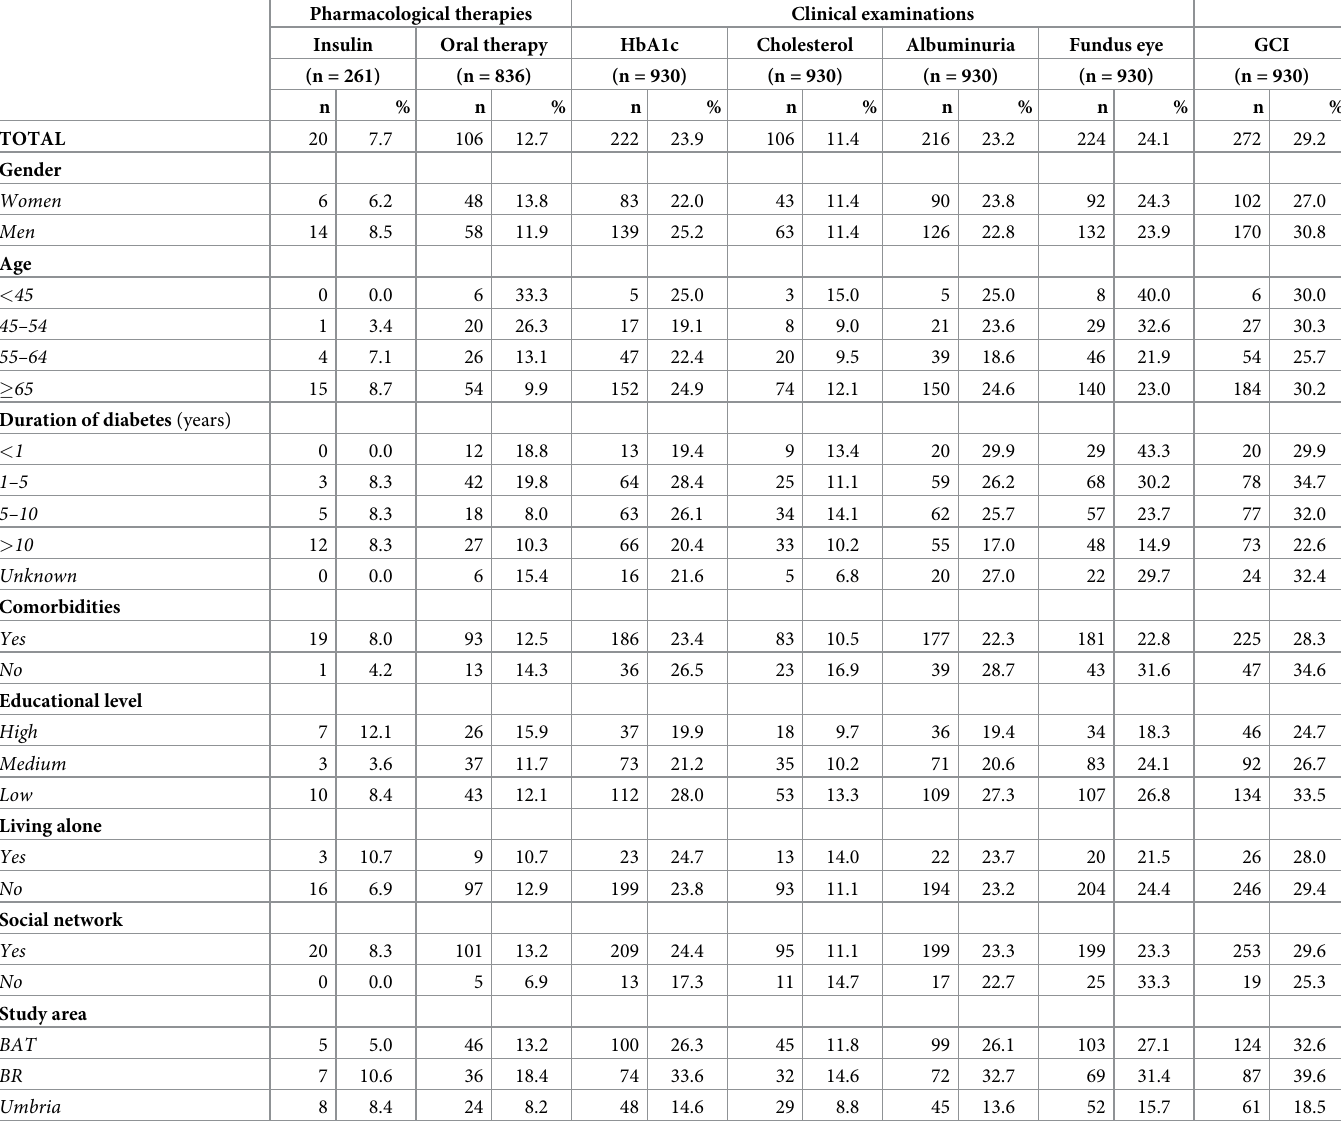
Table 2. Number of cases and prevalence of non-adherence to prescribed pharmacological therapies and recommended clinical examinations by patient